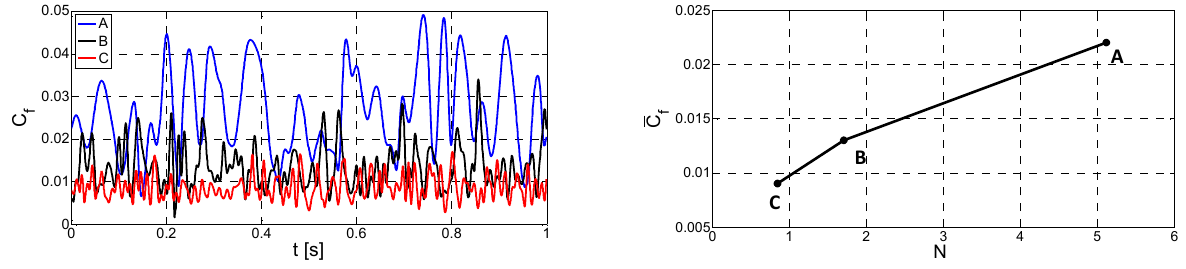
Figure 17. Skin-friction coefficient C f versus time and its average value C f as function of the Figure 17. Skin ‐ friction coefficient (cid:1829)(cid:1858) versus time and its average value (cid:1829)(cid:1858)(cid:3364)(cid:3364)(cid:3364)(cid:3364) as function of the N N parameter. Figure 17. Skin ‐ friction coefficient (cid:1829)(cid:1858) versus time and its average value (cid:1829)(cid:1858) (cid:3364)(cid:3364)(cid:3364)(cid:3364) as function of the N parameter.